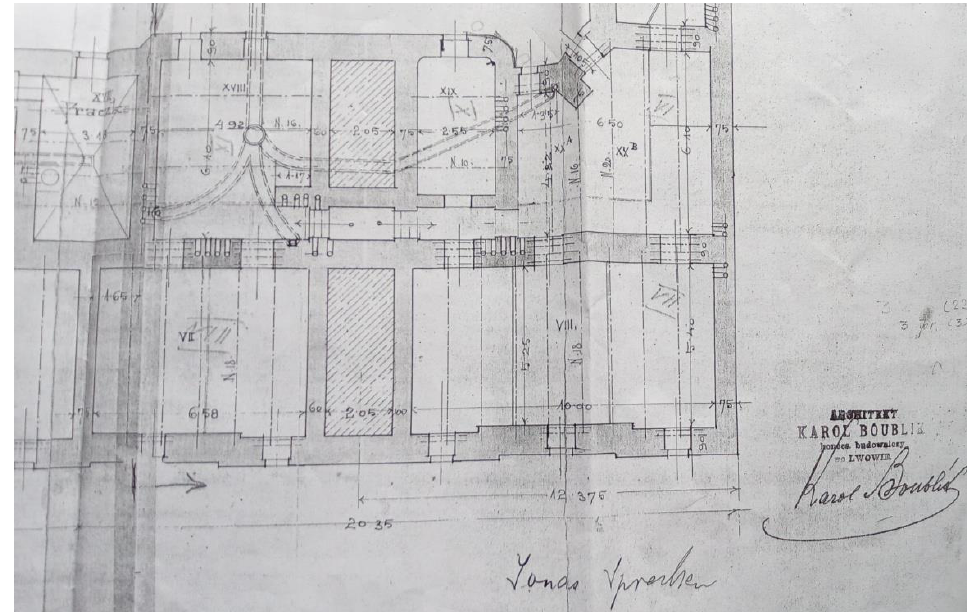
Figure 5. Archival documentation of the building under study—existing fragment of the ground floor plan.